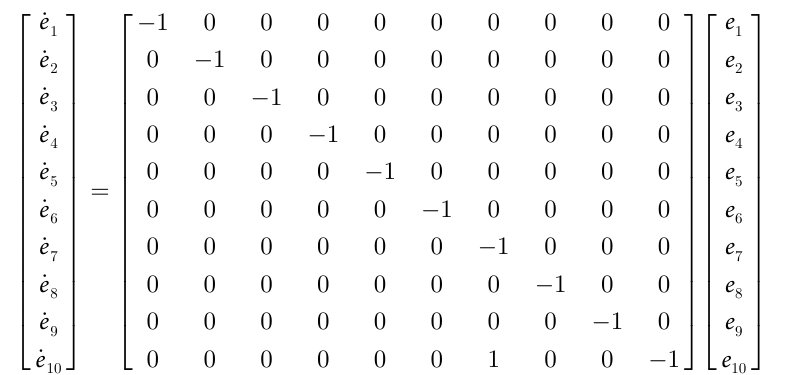
states error time evolution are depicted in Fig 20. The results shows that all the ten states of error system (22) evolve chaotically with time when the active controllers are deactivated (when t < 200 s ) indicating non synchronization. After that (when t � 200 s ), the controllers are activated and it can be seen that all the states synchronization error converge rapidly to zero. So, simulation results showing the success of the proposed active controllers (23) to syn- chronize the new 10D hyperchaotic system with a class of three multidimensional chaotic